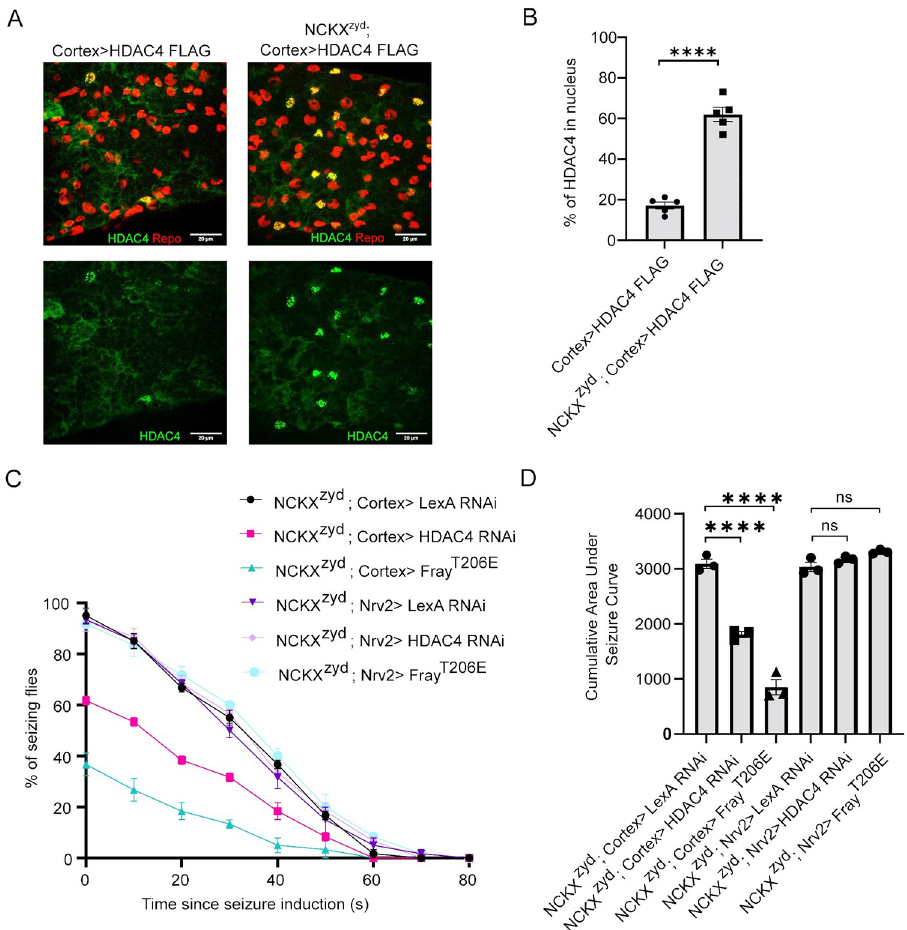
Fig 6. Enhancing glial K + buffering in cortex glia suppresses seizure behavior in NCKX zyd . Representative images of ventral nerve cord showing HDAC4 localization in cortex glia of NCXK zyd mutants. (B) Quantification of percentage of HDAC4 in glial nuclei for genotypes in (A). Data are represented as HDAC4 in the nucleus divided by the total amount of HDAC4, expressed as a percentage. (C) Time course of vortex-induced seizures in NCKXzyd with Fray overexpression or HDAC4 knockdown in wrapping glia (NCKXzyd; Nrv2 > ) and cortex glia (NCKXzyd; Cortex glia). UAS-LexA RNAi was used as a control transgene in each glial subtype. After seizure induction, the number of flies seizing were recorded every 10 seconds and plotted as a percentage of seizing flies. n � 3 groups of 10–20 flies per genotype per time point. (D) Quantification of area under the seizure curve for genotypes in (B). Statistical significance was determined using one-way ANOVA with Sidak’s multiple comparisons test; NS = not significant, ���� p < 0.0001. influence HDAC4 localization (Fig 1). Next, we asked whether the inhibition of SIK3-HDAC4 K + buffering pathway in cortex glia contributes to the seizure behavior of the NCKX zyd mutants by testing whether reactivating this pathway in cortex glia could suppress their seizure behavior. To enhance K + buffering in cortex glia, we used a cortex specific Gal4 driver to knockdown HDAC4 or overexpress a constitutively active Fray in wild type and NCKX zyd mutant flies. Enhancing K + buffering in cortex glia dramatically suppressed seizure behaviors in NCKX zyd mutants, leading to a significantly decreased integrated seizure response com- pared to NCKX zyd mutants expressing a control transgene (Fig 6C and 6D). Enhancing K + buffering in wrapping glia did not influence seizure behavior, highlighting the importance of cortex glial regulation of seizure behavior. These findings show that the NCKX zyd mutant impacts not only Ca 2+ signaling and sandman endocytosis [18] but also the SIK3 K + buffering